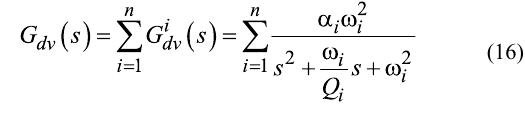
first denoted the voltage driven arrangement, is a grounded load